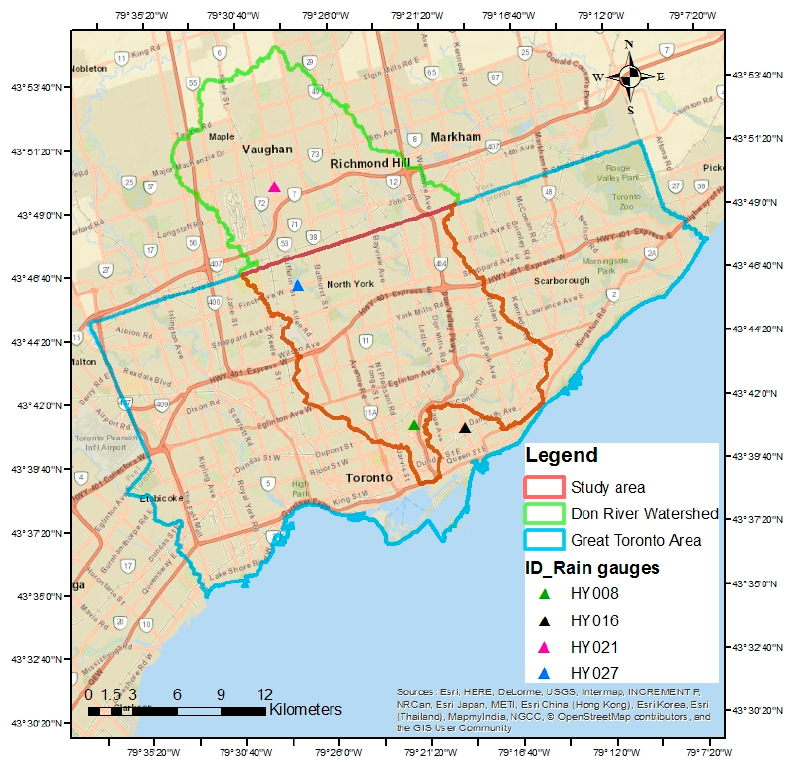
Figure 1. Study area: intersection between the Greater Toronto Area and the Don River watershed and the rain gauges.